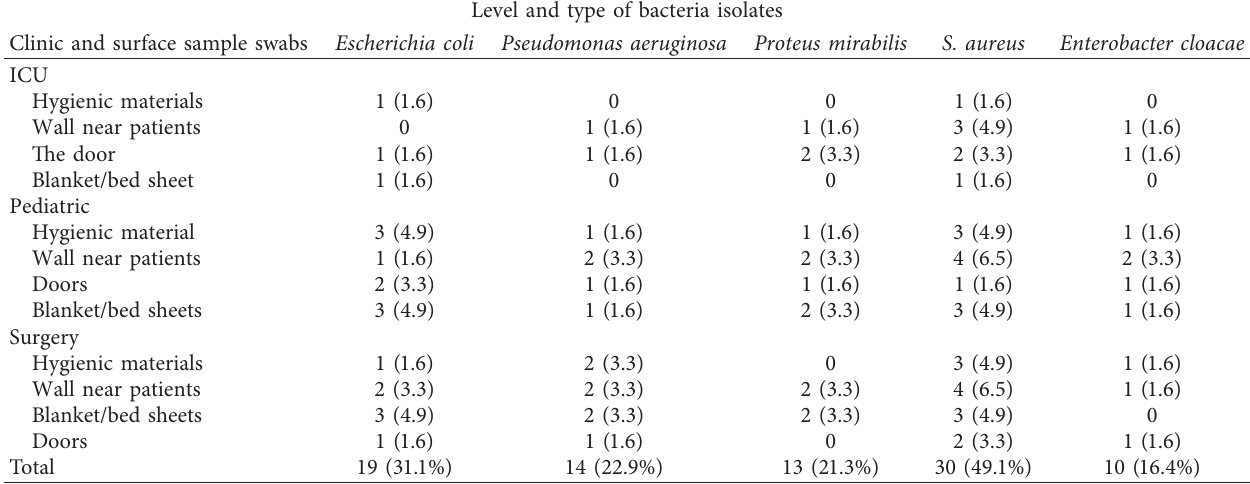
Table 2: Bacterial contamination from clinic items and working surface.